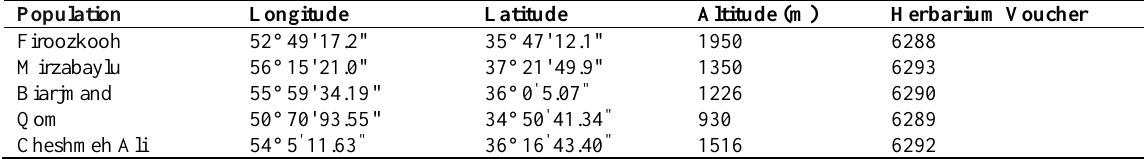
Table 1 . List of monitoring sites with wild L. undulata populations in Iran in 2018. Herbarium Vouchers were lodged at Golestan University